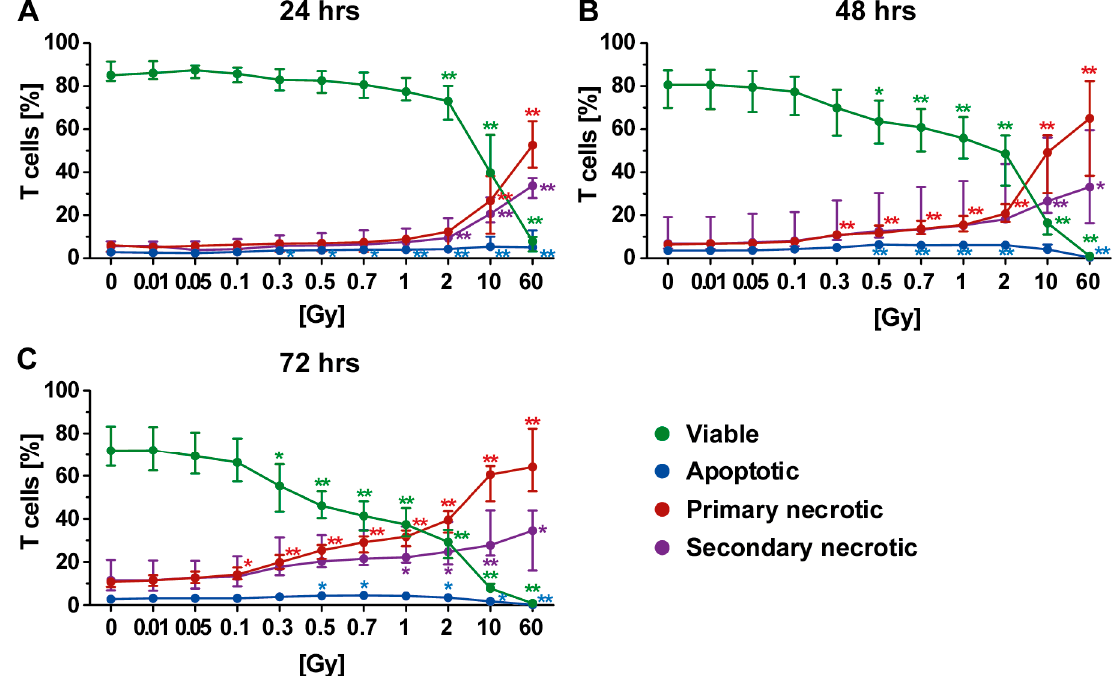
Figure 3. Forms of cell death in T cells at different time points after irradiation. ( A – C ) A radiation dose-dependent decrease in viable T cells (green) was observed. In particular, steady increases in primary (red) and secondary necrosis (violet) were identified to be linked to radiation dose. In contrast, the apoptosis rate (blue) seemed only to be marginally affected by radiation, suggesting that the T cells rapidly undergo secondary necrosis. ( A – C ) The colored dots represent the percentage distribution of viable (green), apoptotic (blue), primary (red), or secondary necrotic (violet) T cells as determined by AxPI staining and flow cytometry analyses at ( A ) 24, ( B ) 48, or ( C ) 72 h after irradiation. Each data point represents the median ( ± IQR) from six independent experiments from three different donors. Data points have been connected by lines to improve visual clarity. Statistical analyses were performed against the corresponding nonirradiated control (0 Gy) using the Mann–Whitney U test (* p < 0.05; ** p < 0.01).